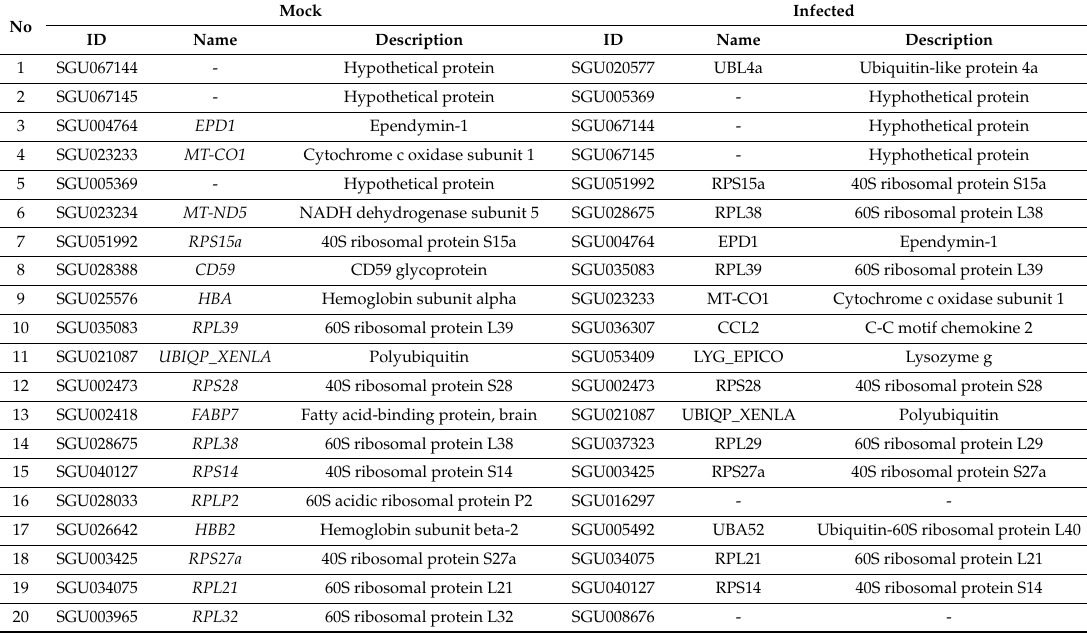
Table 2. The top 20 most abundant